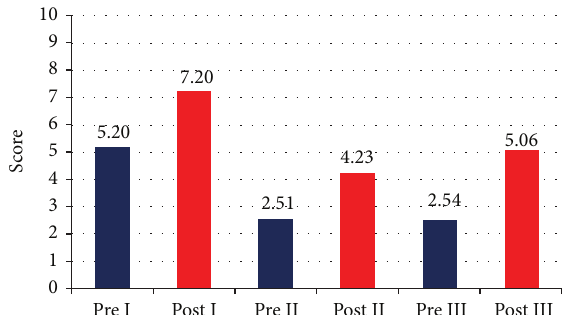
Figure 7: Breakdown of the scores for each part of the algorithm